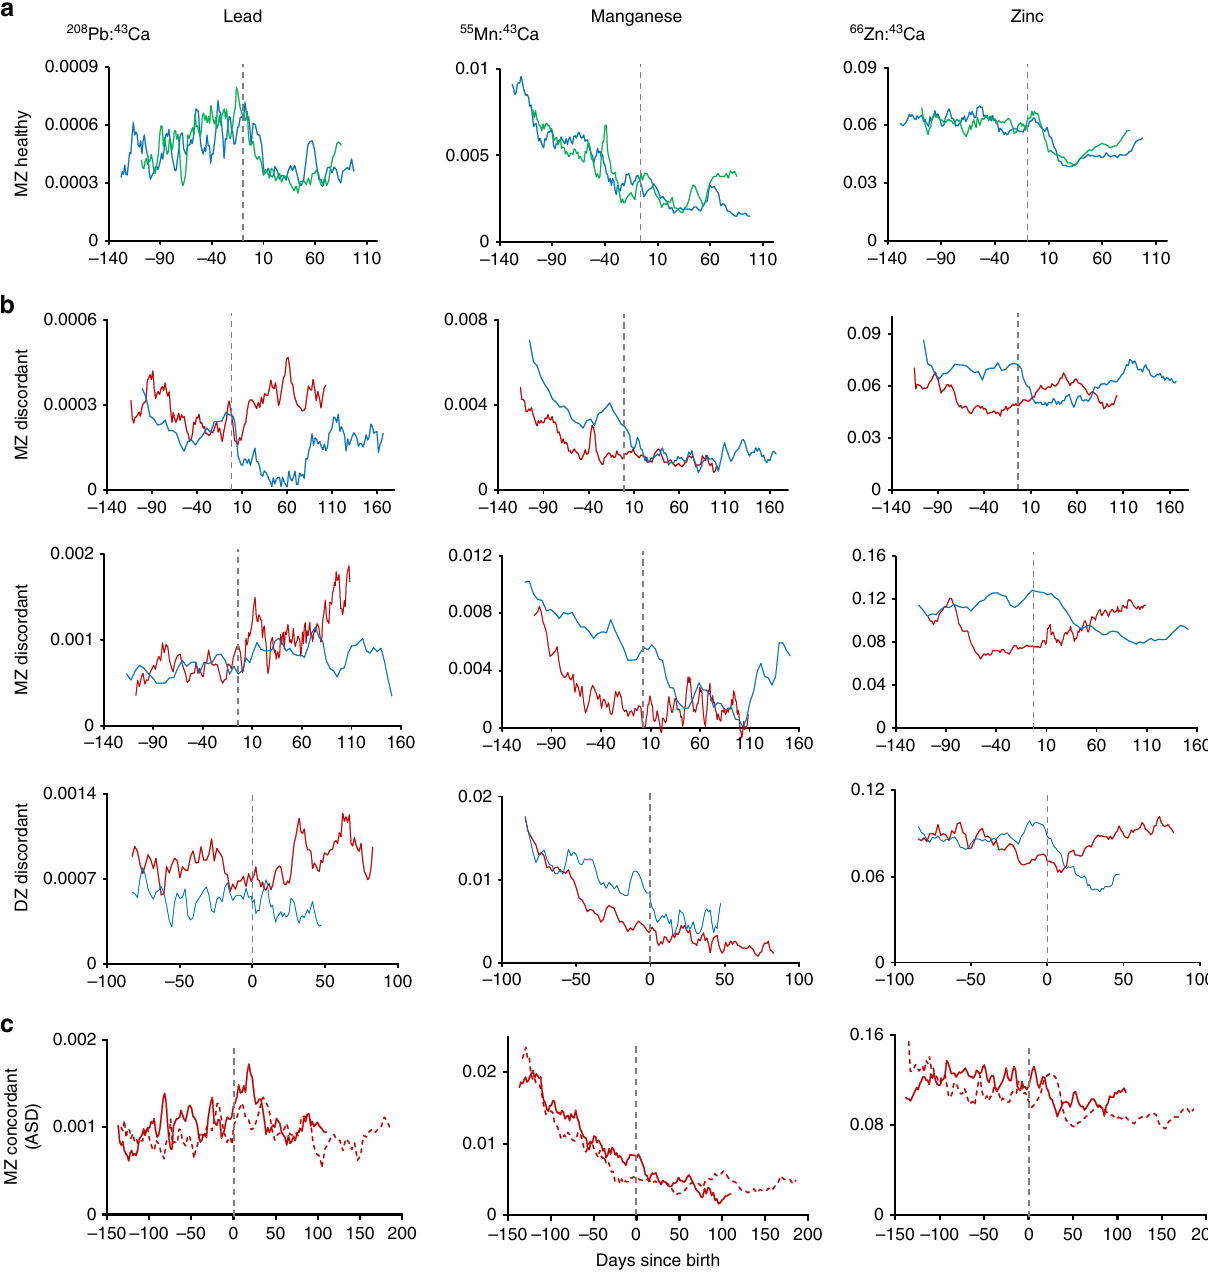
Figure 3 | Pre- and postnatal differences in metal uptake between non-ASD control and ASD discordant and concordant twin pairs. Patterns in lead, manganese and zinc distribution over the developmental period studied are shown for ( a ) non-ASD control monozygotic (MZ) twin pair, ( b ) ASD discordant MZ and dizygotic (DZ) twin pairs and ( c ) ASD concordant MZ twin pair. Red lines indicates ASD twins and blue/green, control co-twins. Grey dashed line denotes time of birth. Element levels are reported as metal ion counts ( 208 Pb, 55 Mn, or 66 Zn) relative to an internal standard ( 43